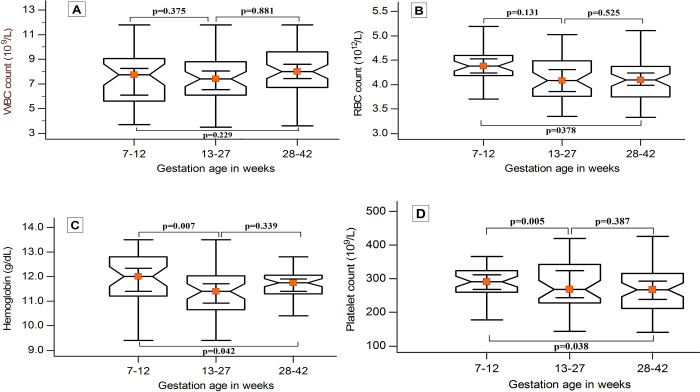
Box and whisker plots showing the comparison of selected hematologic parameters (A: WBC count (x109/L), B: RBC count (x1012/L, C: Hgb (g/dL), D: PLT count (x109/L)) by gestational age among pregnant women (n: 1st trimester = 48, 2nd trimester = 56, 3rd trimester = 53) in Dire Dawa town, Ethiopia from January-March, 2019.